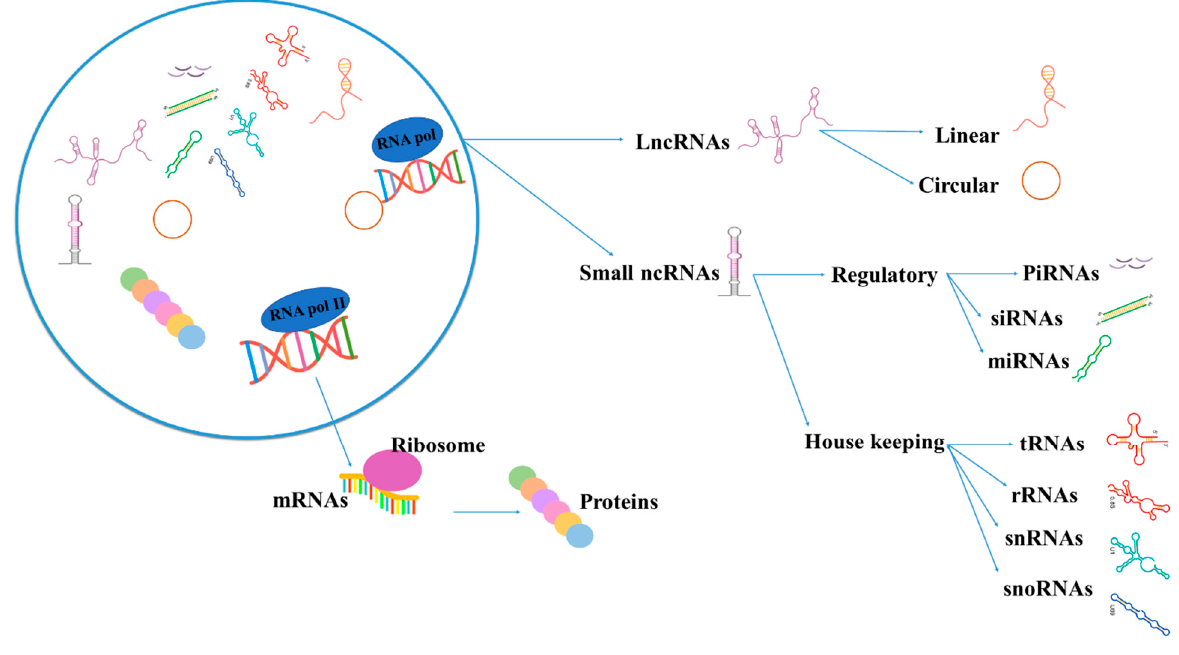
Figure 1. The image depicts the classification of ncRNAs : rRNA, ribosomal RNA; tRNA, transfer RNA; snRNA, small nuclear RNA; snoRNA, small nucleolar RNA; miRNA, microRNA; siRNA, small interfering RNA; PiRNA, Piwi-interacting RNA; lncRNA, long noncoding